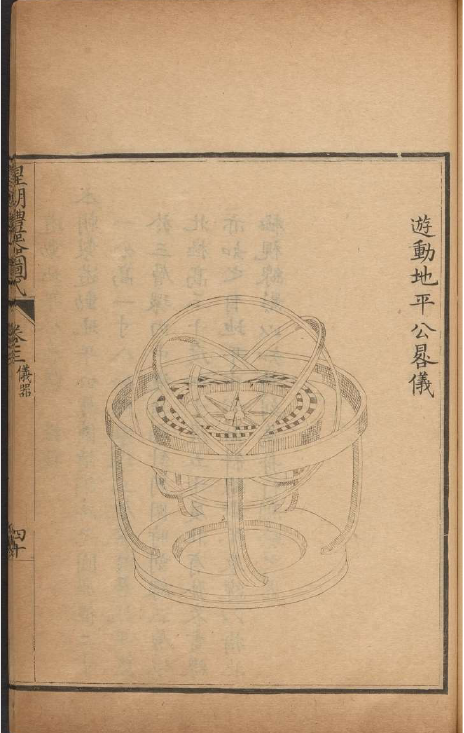
Figure 6. A Chinese, gimbal-mounted azimuth compass from Huangchao liqi tushi 皇朝禮器圖式 (The illustrated catalogue of imperial ritual instruments), vol. 3, p. 40. Published by Wuying dian 武英殿 in Qianlong’s reign (1759–1795). Harvard Yenching Library.